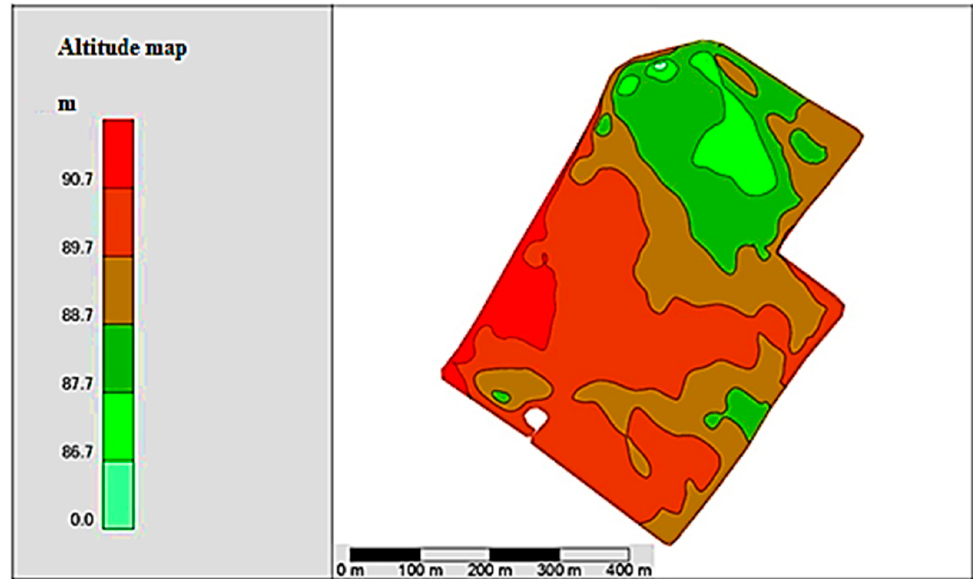
Figure 4. Elevation map representing relief differences in the field. The colored parameter variation internal maps were created by the authors using a Veris MSP